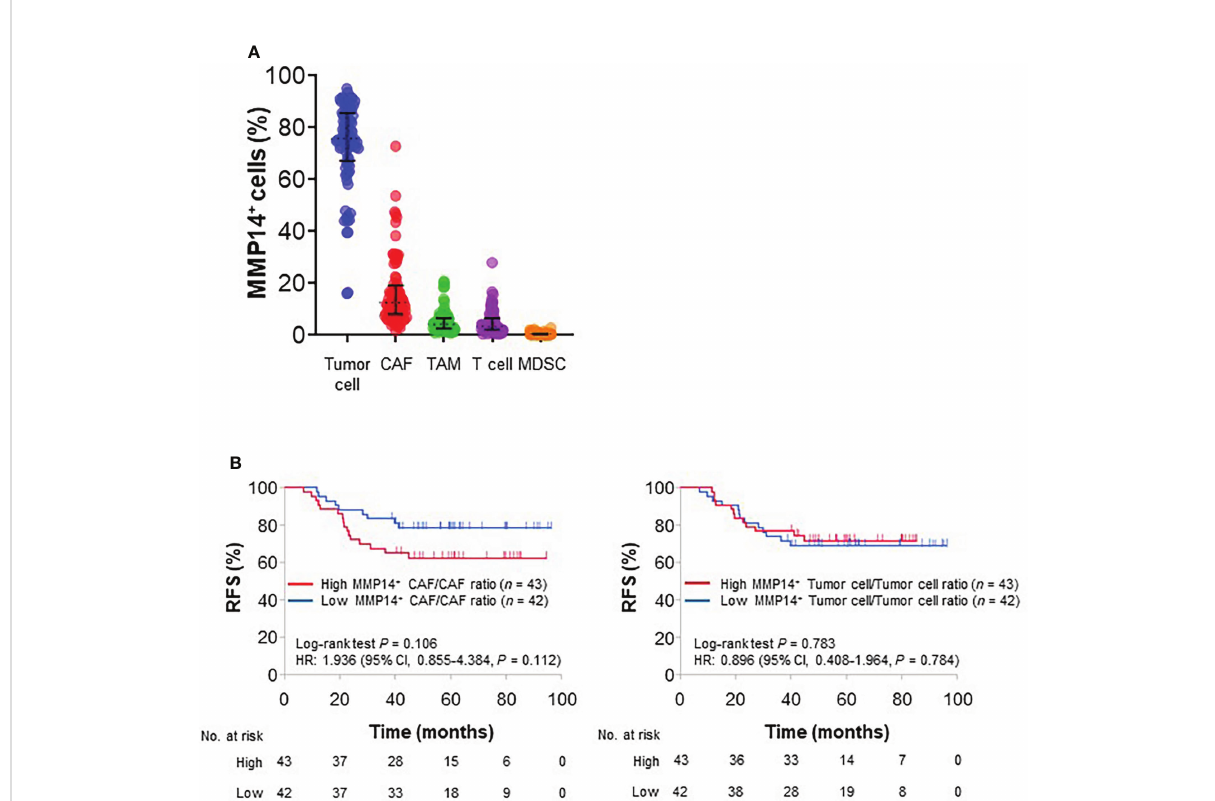
FIGURE 3 Prognostic impact of MMP14-expressing cells. (A) Percentage of MMP14-expressing cells among cell subsets as determined by mIHC analysis. Each dot represents one patient, and the median value and interquartile range are shown for each plot. (B) Kaplan-Meier curves for RFS according to the median values of the MMP14 + CAF/CAF ratio (left) or the MMP14 + tumor cell/tumor cell ratio